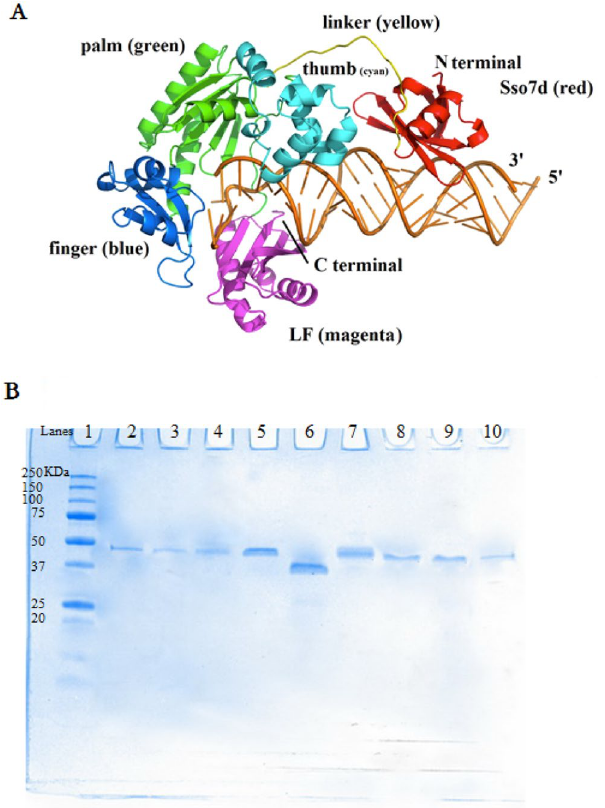
Figure 1. ( A ) A ribbon diagram of Dbh complexed with Sso7d and DNA. The location of the four structural domains in Dbh are color coded as follows: green, palm domain; cyan, thumb domain; blue, finger domain; magenta, little finger (LF) domain; red, Sso7d. Sso7d is located at the N-terminus and is covalently linked to the palm domain. Sso7d binds to DNA by placing a triple-stranded beta-sheet across the DNA minor groove. The amino acid sequence of the flexible linker (yellow) is SS(GGGGS) 3 GM. The DNA substrate is shown in brown. ( B ) SDS-PAGE of the purified Dbh and the variants. Samples were separated on a 10% Mini-PROTEAN TGXTM precast gel (Bio-Rad) and proteins were visualized after staining with Coomassie Brilliant Blue R-250. Lane 1, protein marker (protein molecular weight (kDa) was showed on the left of the lane 1); Lane2-10, SdbhM76I, SdbhKSKIP241–245RVRKS, SdbhL250V, Sdbh, Dbh, SdbhT37F, SdbhA221S, SdbhI62V and SdbhK337R,